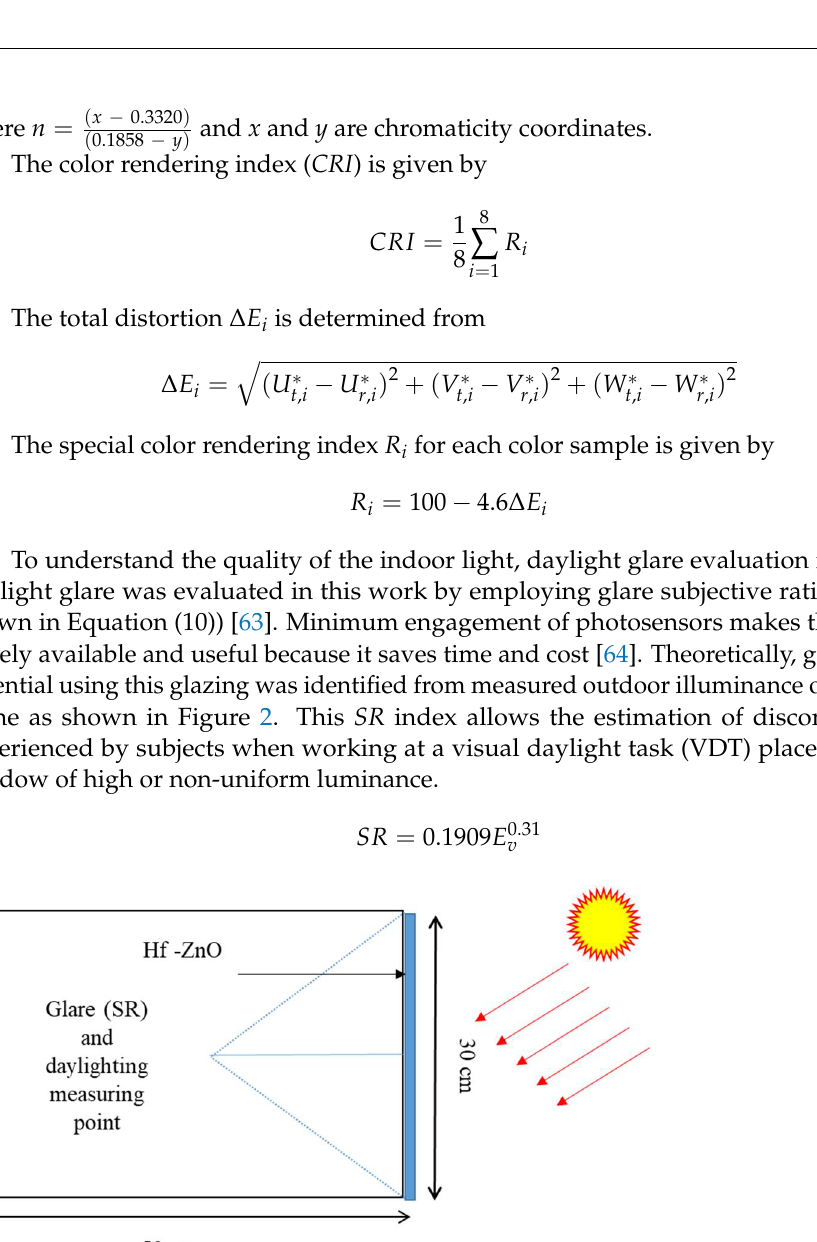
Table 1. Criterion scale of discomfort glare subjective rating (SR)